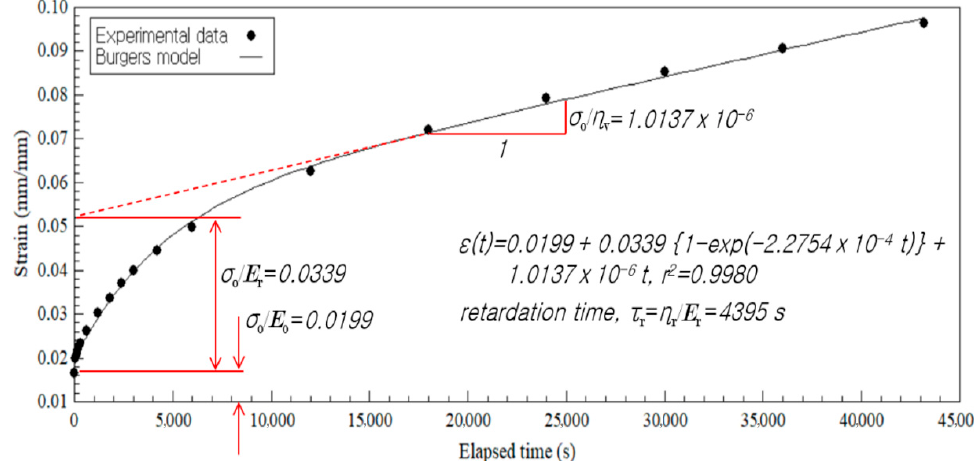
Figure 9. Example of the constant value determination for the Burgers model, using nonlinear regression analysis of measured data: ρ = 20 kg/m 3 , σ o = 0.0791 MPa.